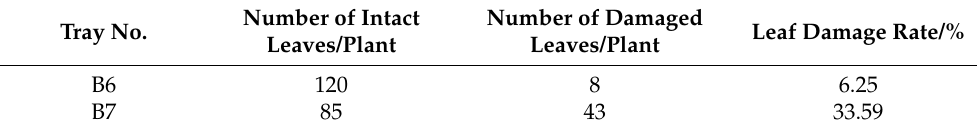
Table 5. Comparison table of the injury before and after position posture judgement.